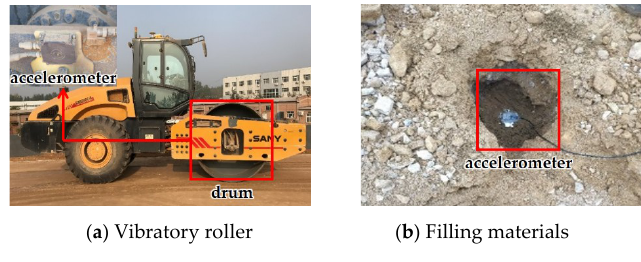
Figure 3. Accelerometers used in the test.